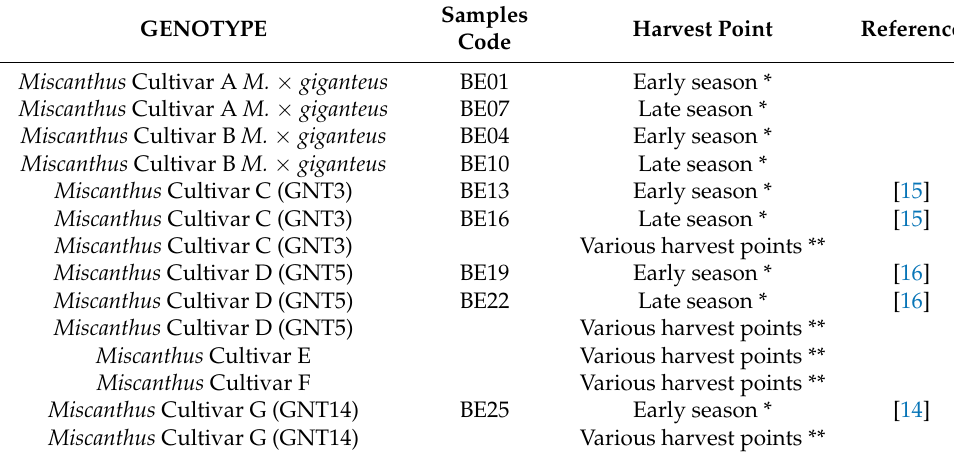
Table 1. Miscanthus cultivars analysed in this